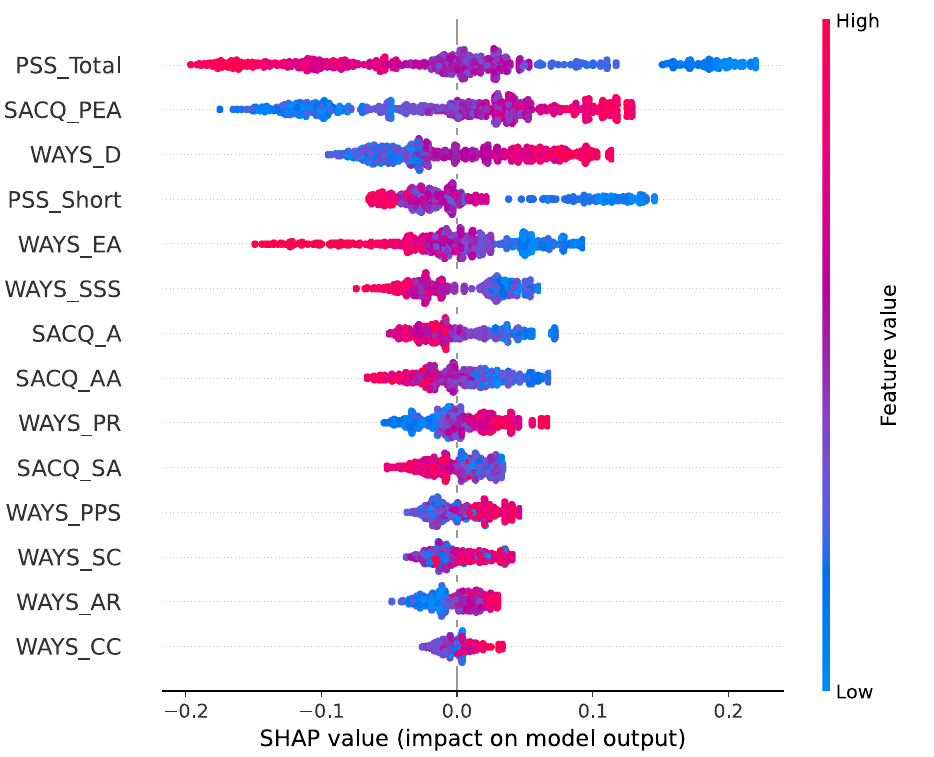
Fig 3. SHAP plot for emotionality adjustment using the random forest